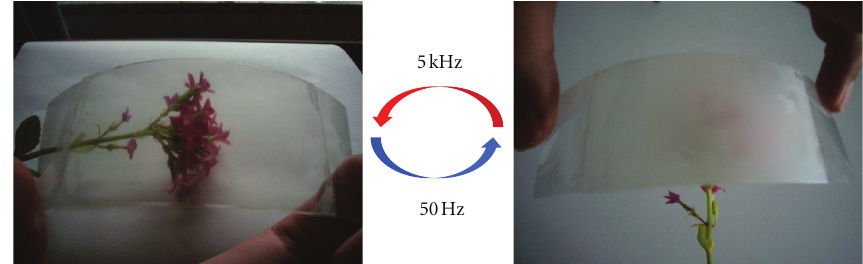
Figure 8: Pictures of PWSLC on flexible PET substrate; no voltage is applied to maintain their optical states.